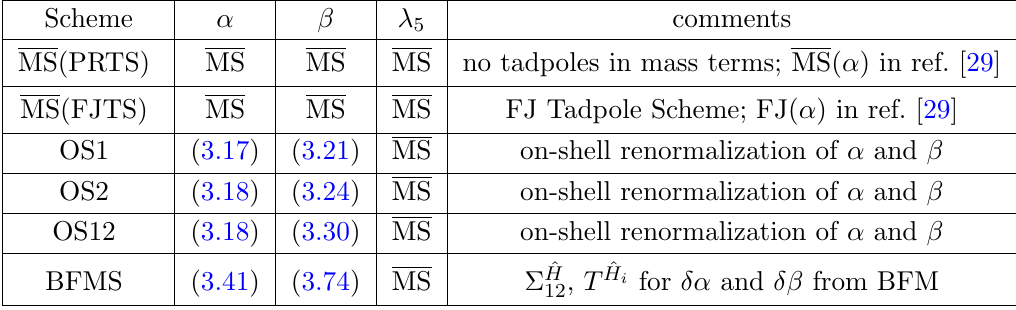
Table 2 . Summary of renormalization schemes used in the